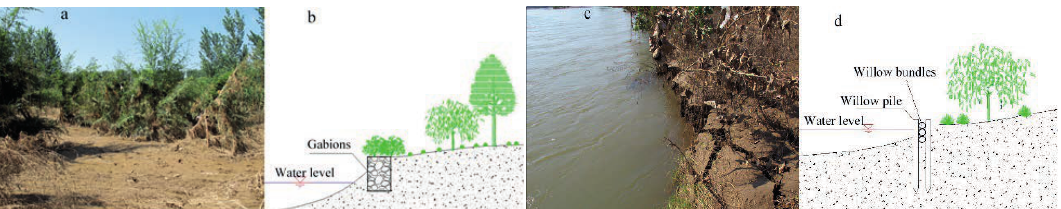
Fig. 2 Flood interference: (a) The vegetation was inundated by floods from Daling River leaving the anti- waterlogging species with poor growth; (b) design of the gabion revetment. Flood interference: (c) River banks collapse due to water washing; (d) design of the willow pile